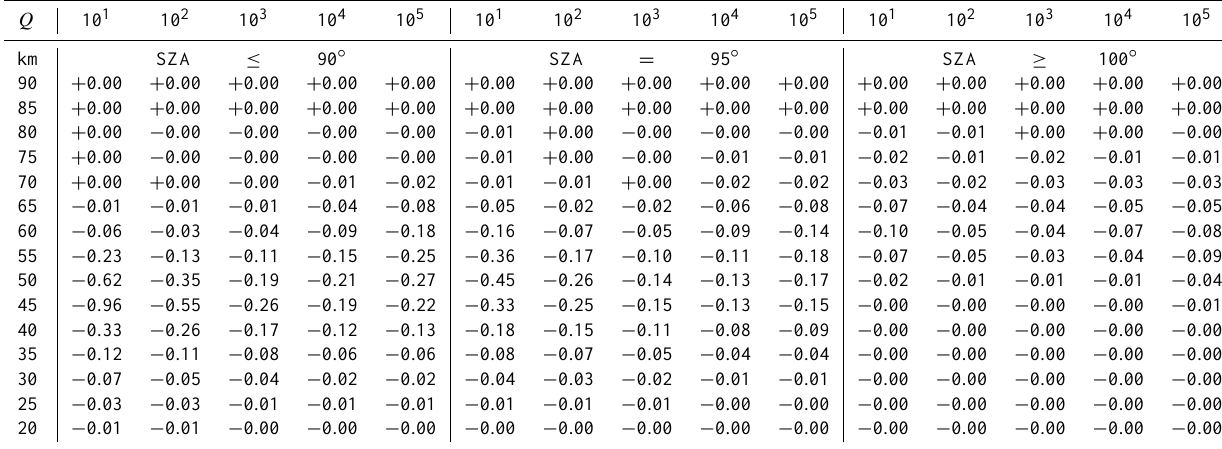
Table A21. P NO /Q for October NH.